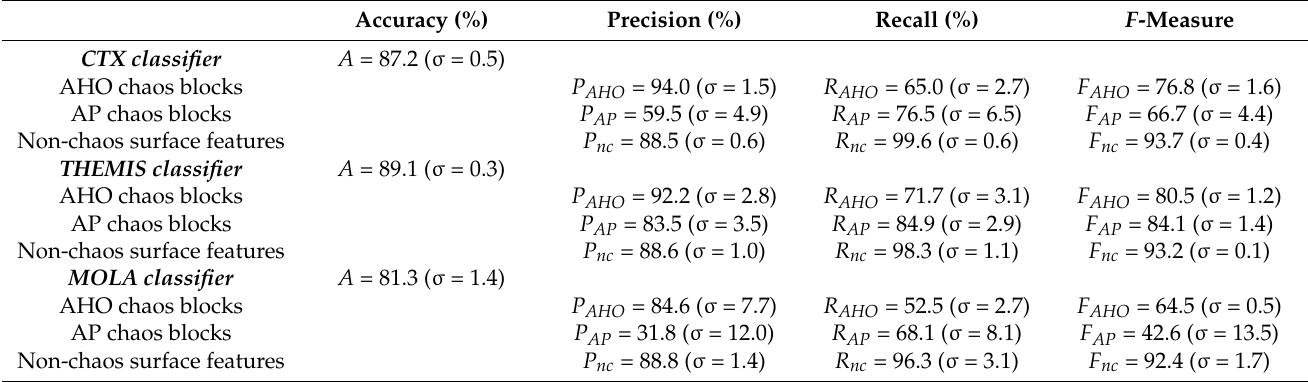
Table 2. Same as Table 1 but using the split dataset of AHO chaos blocks for testing and training based on the region of the chaos terrains (i.e., the images from Aromatum Chaos, Hydaspis Chaos, Iamuna Chaos, and Oxia Chaos for testing, and the images from Hydraotes Chaos, Adam Chaos, and Echus Chaos for